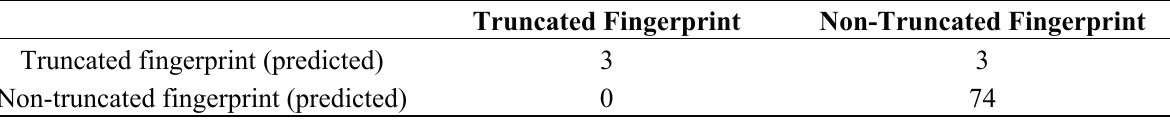
Table 5. The predicated results for public database FVC2004 DB3.